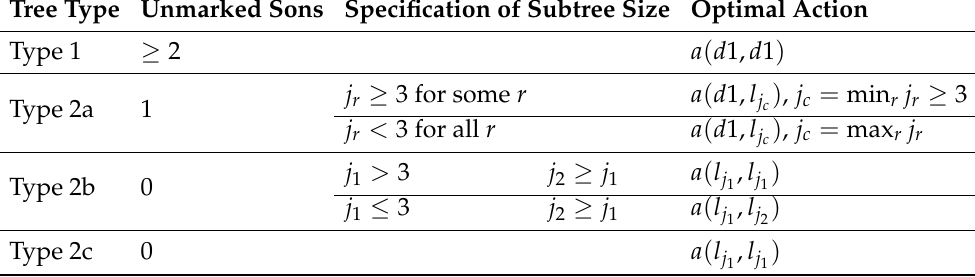
Table 2. Specification of the greedy finite optimal policy.